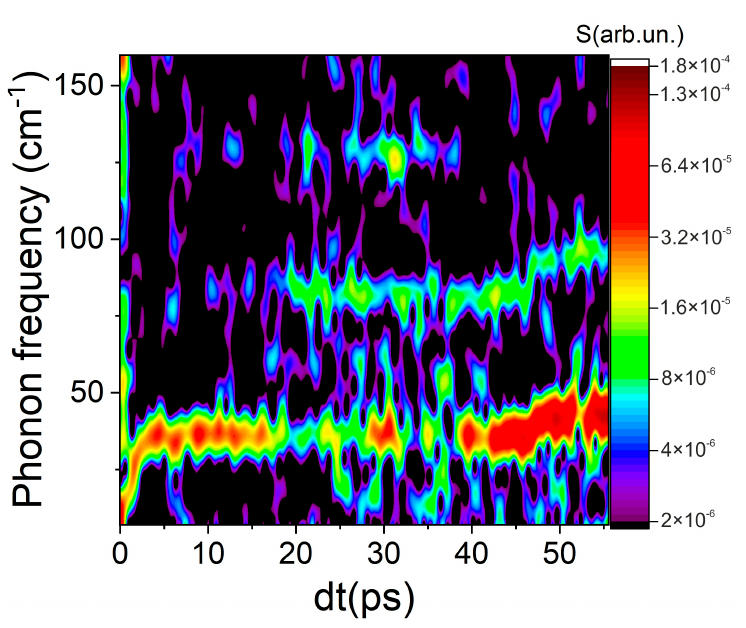
Figure 4. Intensity map of changes in the frequency of coherent phonons in silicon, depending on the delay between the pump and probe pulses. The coherent phonons were generated on timescales greater than 300 fs. For lower